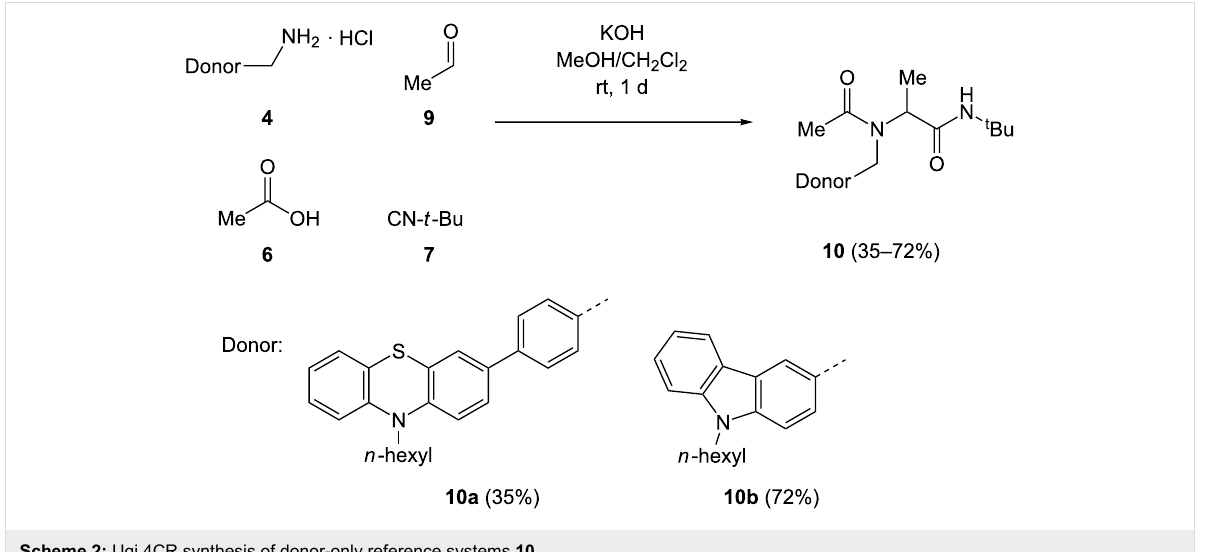
Scheme 2: Ugi 4CR synthesis of donor-only reference systems 10 .